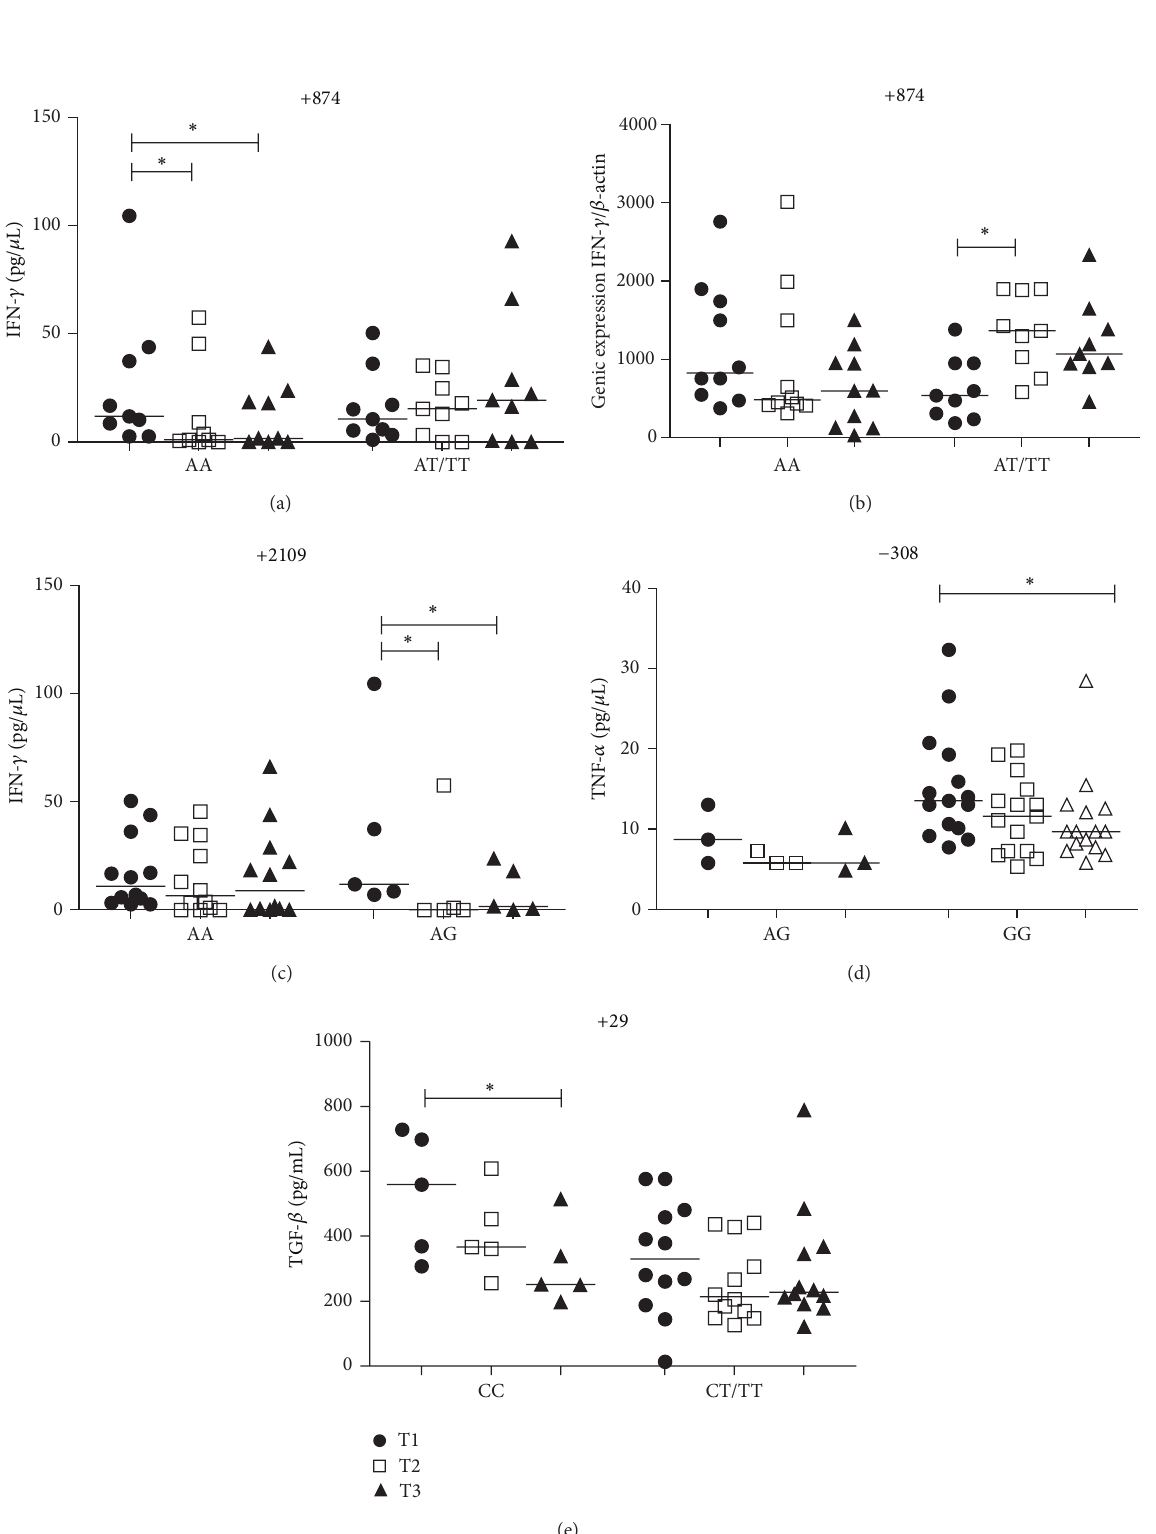
Figure 8: Influence of IFNG +874T/A gene SNP on IFN- 𝛾 plasma levels (a) and mRNA expression (b), IFNG +2109A/G gene SNP on IFN- 𝛾 plasma levels (c), TNF − 308G/C gene SNP on TNF- 𝛼 plasma levels (d), and TGFB1 +29C/T gene SNP on TGF- 𝛽 plasma levels (e) in PTB patients that have all three time points of the treatment: T1 (after diagnosis and first month), T2 (three months), and T3 (six months). Data are shown as median levels. ∗ 𝑃 < 0.05